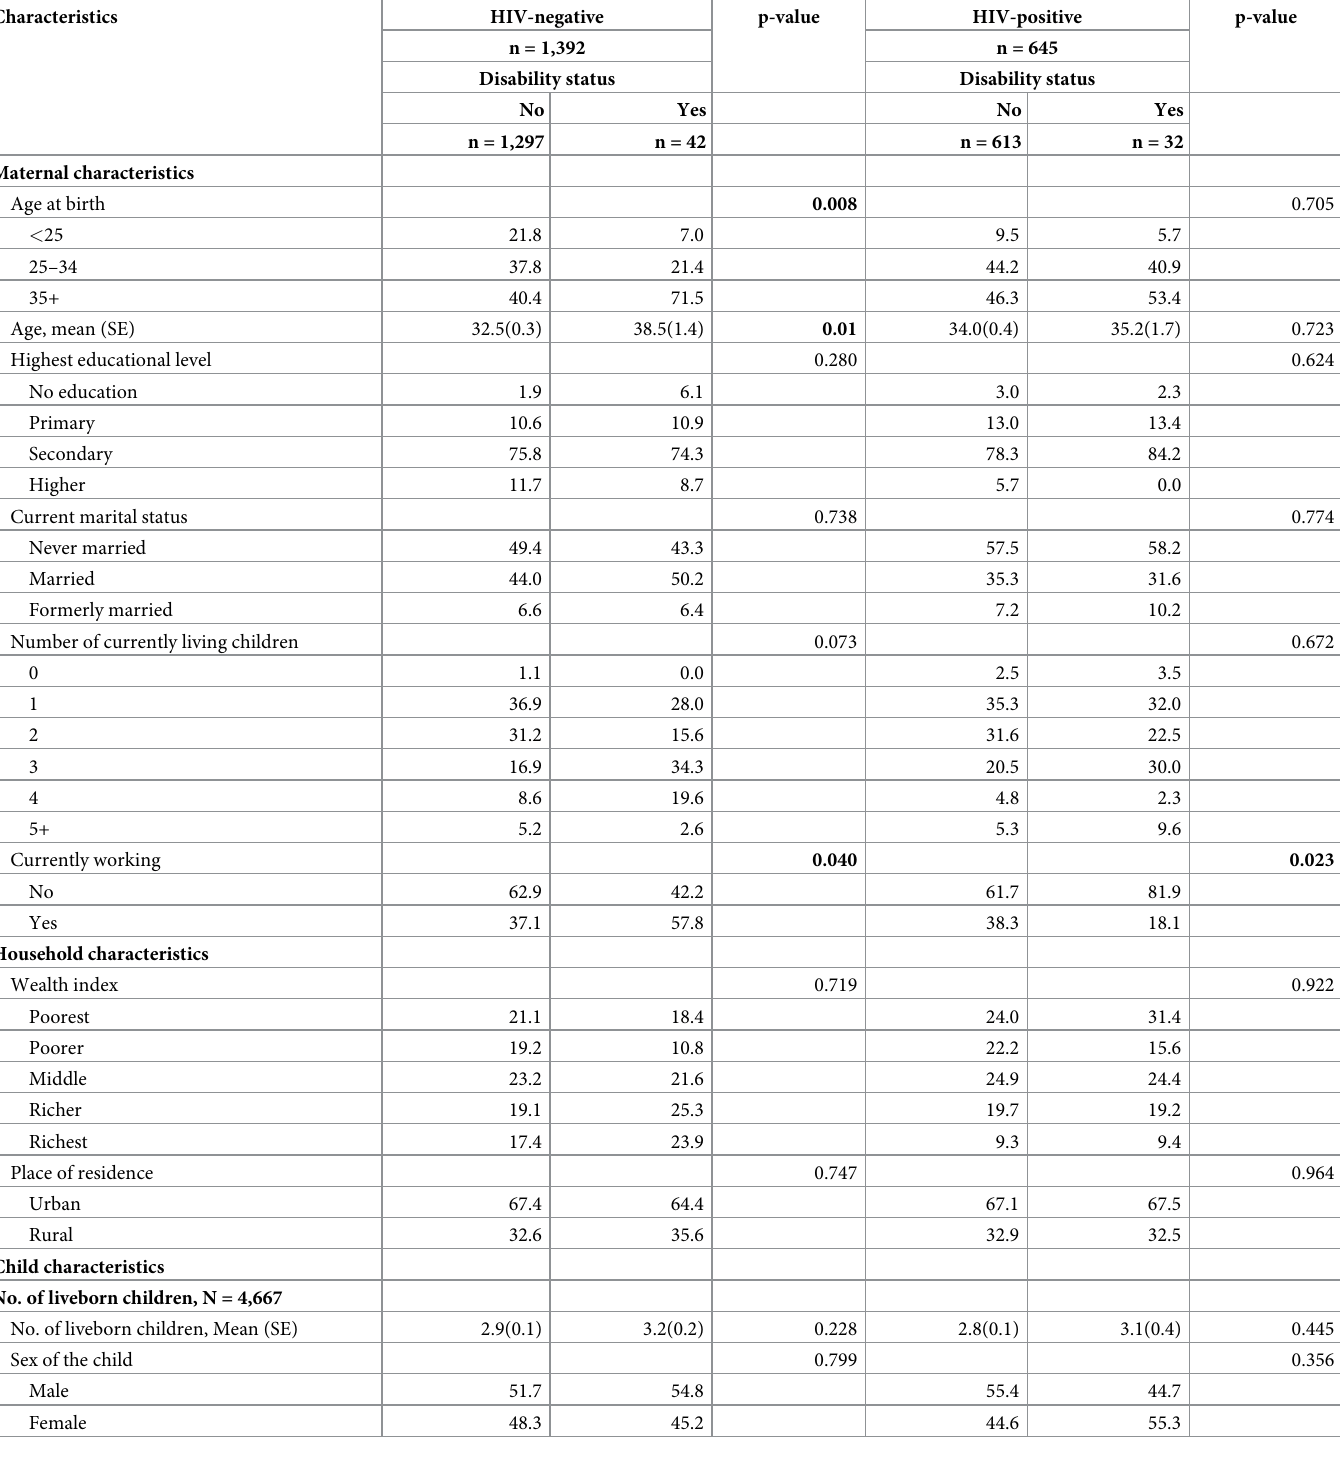
Table 1. Description of the sample of mothers 15–49 years old who gave birth to a live-born child by disability and HIV status, South Africa, 2016, N = 1,984 (weighted percentages).